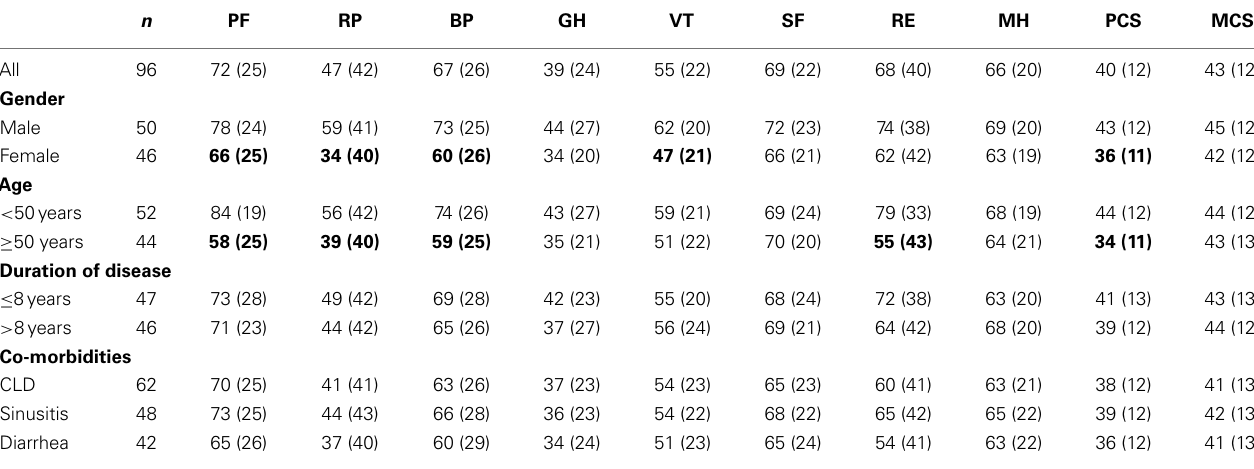
Table 1 | SF-36 mean values (SD) and clinical characteristics of CVID patients .